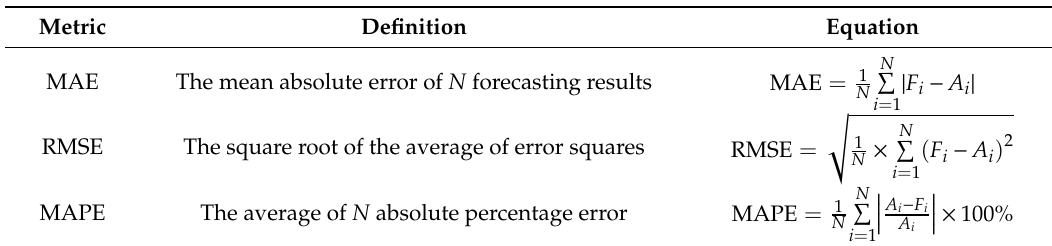
Figure 2. Location of electric load and data structure. Table 2. Three error